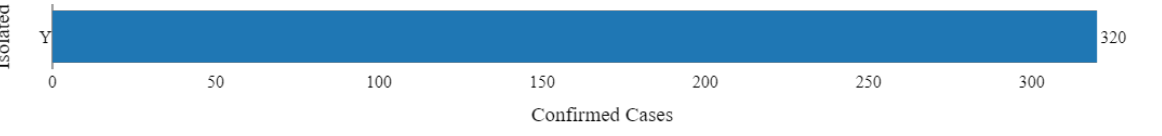
Figure 13. Number of confirmed cases with isolation record.